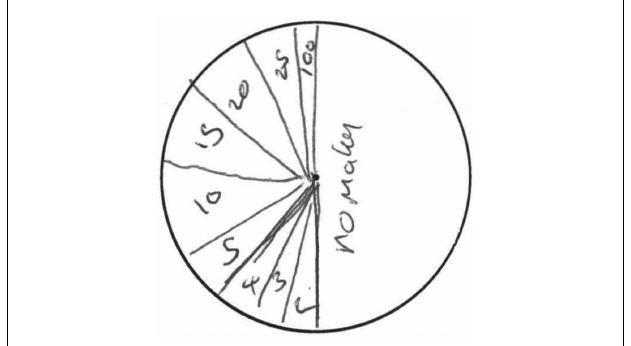
FIGURE 2 | Example of a participant’s hand-drawn initial judgment of a machine’s underlying probability distribution of outcomes. This participant indicated that the possible outcome space included 0, 2, 3, 4, 5, 10, 15, 20, 25, and 100 pence outcomes and that the most likely outcome would be of no matching symbols, or 0